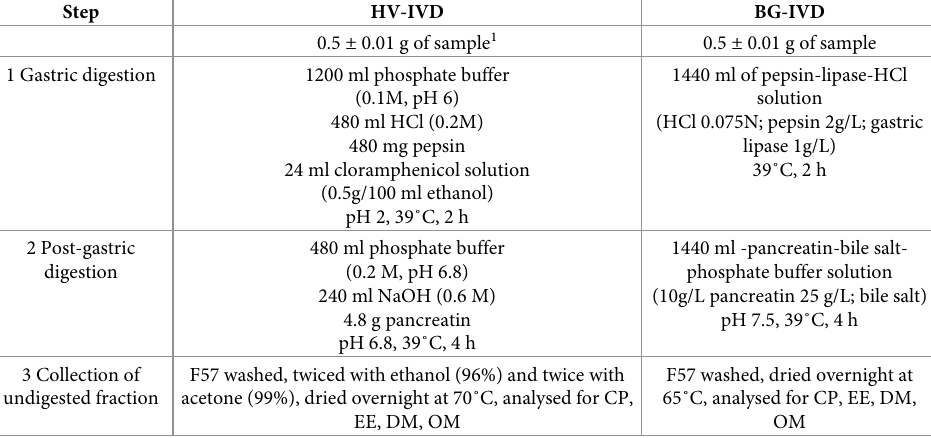
Table 4. In vitro digestibility using the Daisy II Incubator and according to the method described in Hervera et al. [38], (HV-IVD) and in Biagi et al. [39],